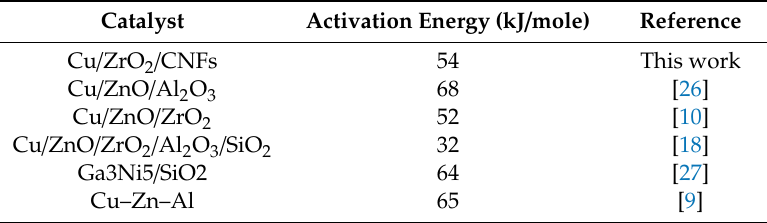
Figure 3. Arrhenius plot of CO 2 hydrogenation. Table 2. Activation energy of CO 2 hydrogenation.